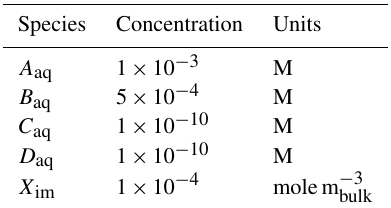
Table 3. Initial concentrations for the batch biodegradation experi- ment. Species Concentration